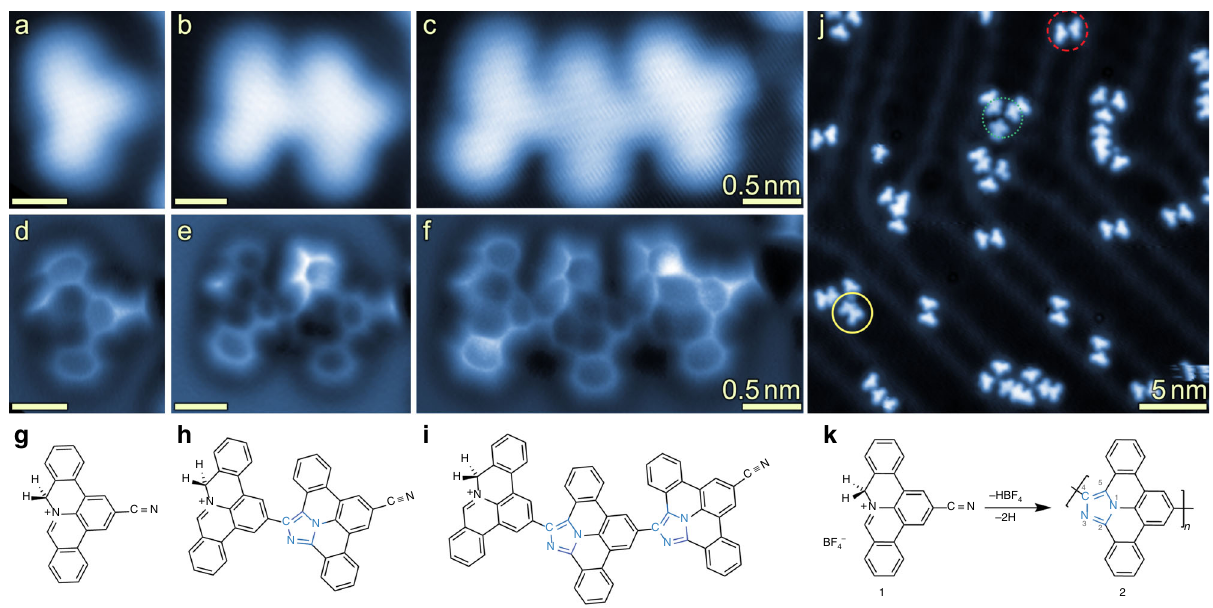
Fig. 2 Head-to-tail coupling of 1 on a Au(111) substrate held at 600 K. a – c STM images of monomeric, dimeric, and trimeric species. d – f Bond-resolved AFM images of the monomer, dimer, and trimer shown in a – c . The images show the formation of an imidazole ring via cycloaddition of the – CN group of one monomer towards the phenanthridinium-derived azomethine ylide moiety of another monomer. g – i Chemical structures of the monomer, dimer, and trimer. The formed imidazole ring is highlighted in blue color. j Overview STM image shows a coexistence of covalently coupled (yellow solid circle) and noncovalently assembled (green dotted and red dashed circles) motifs. k Reaction scheme showing head-to-tail polymerization of 1 upon imidazole ring formation. Scan parameters: ( a , b ) Sample bias V S = 20 mV, tunneling current setpoint I = 5 pA; ( c ) V S = 20 mV, I = 20 pA; ( d – f ) V S = 0 V, oscillation amplitude A OSC = 40 pm, constant height; ( j ) V S = 20 mV, I = 5 pA. Frequency shift ranges, dark to bright: ( d ) − 10.2 to 6.7 Hz; ( e ) − 10.1 to 3.1 Hz; ( f )